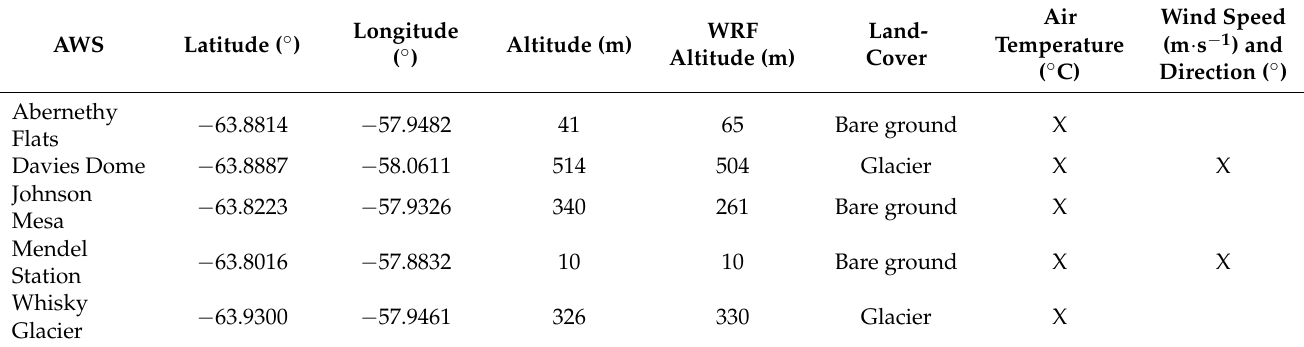
Table 1. Topographic characteristics of automatic weather stations (AWS) in the northern Ulu Peninsula, James Ross Island. The “X” symbol indicates available data. AWS Latitude ( ◦